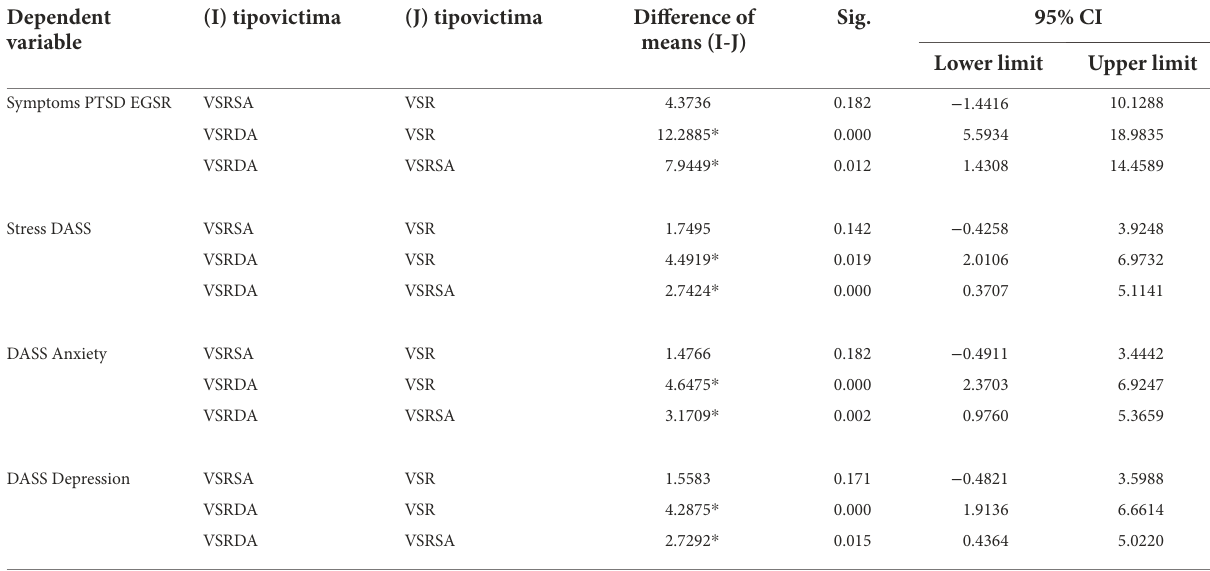
TABLE 2 Clinical setting by victim group.